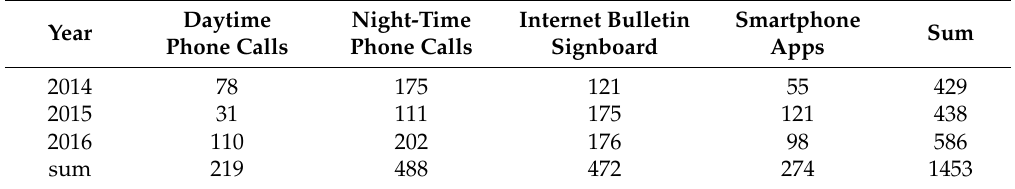
Table 1. Data composition based on reporting channel in Shiheung,